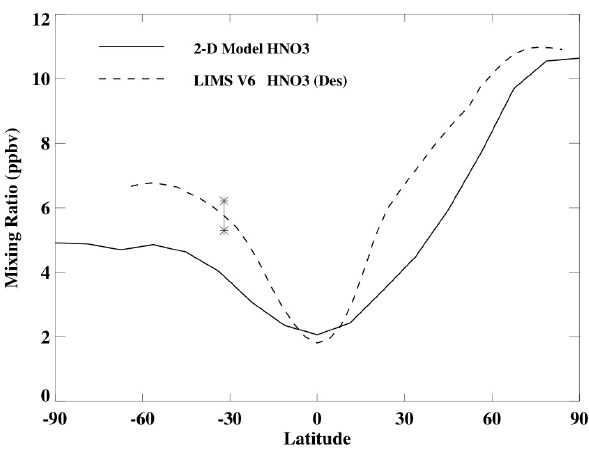
Fig. 7. LIMS V6 (dashed) and model (solid) comparisons for HNO 3 inppbv from the LIMS descending (Des or nighttime) orbital seg- ments of December 1978. The vertical line on the LIMS data at 32 ◦ S denotes its estimated uncertainty.